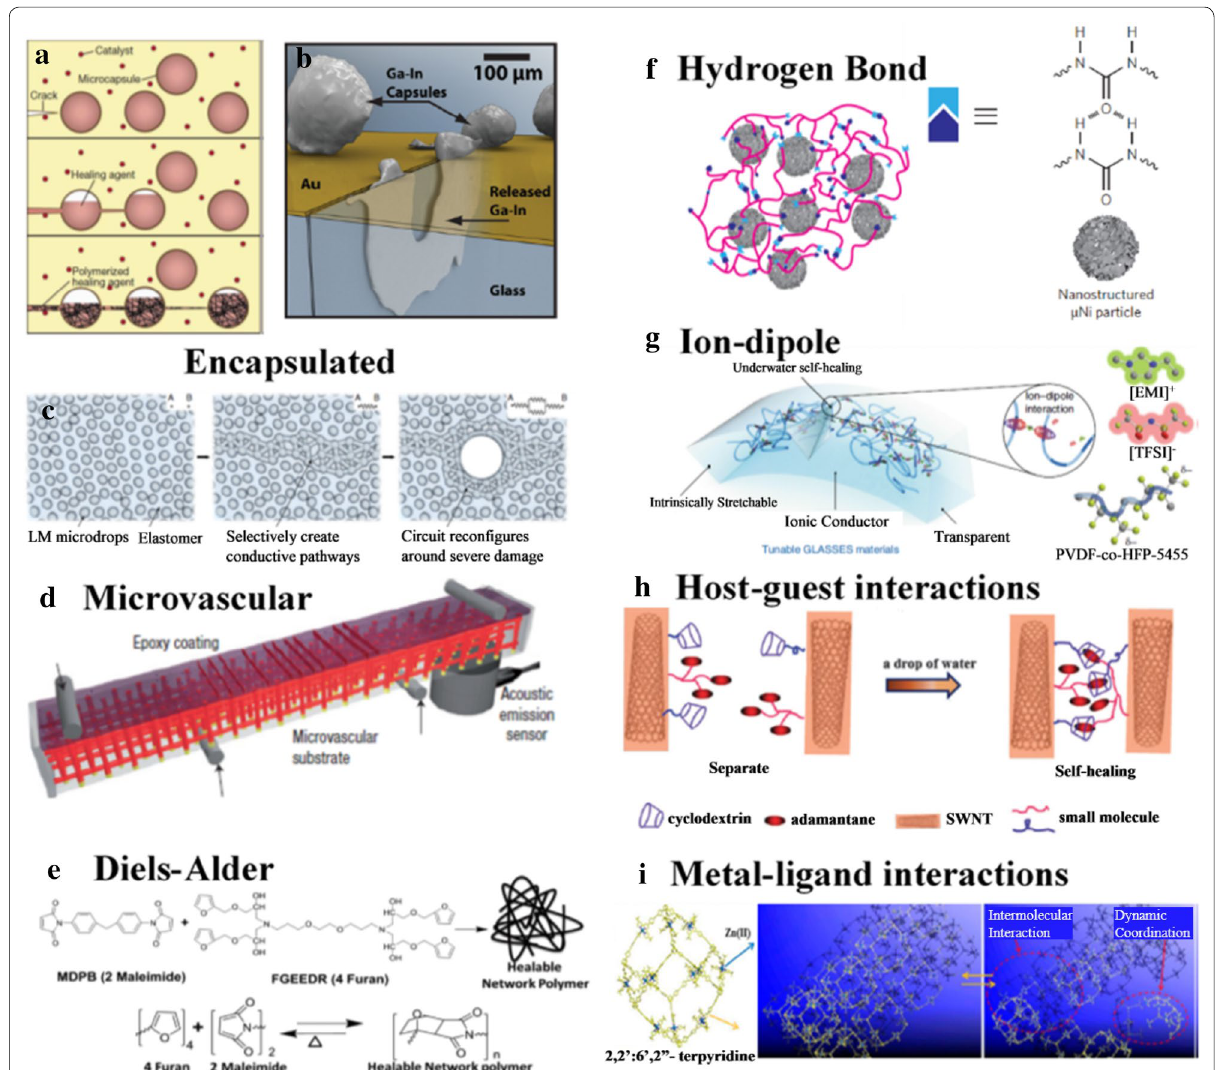
Fig. 5 Self-healing Mechanisms. a Schematic of a crack propagating (top) releasing healing agent (middle) and repair of the crack (bottom). Reproduced in part with permission [163], Copyright 2001, Nature Publishing Group. b Schematic of released GaIn in crack plane. Reproduced